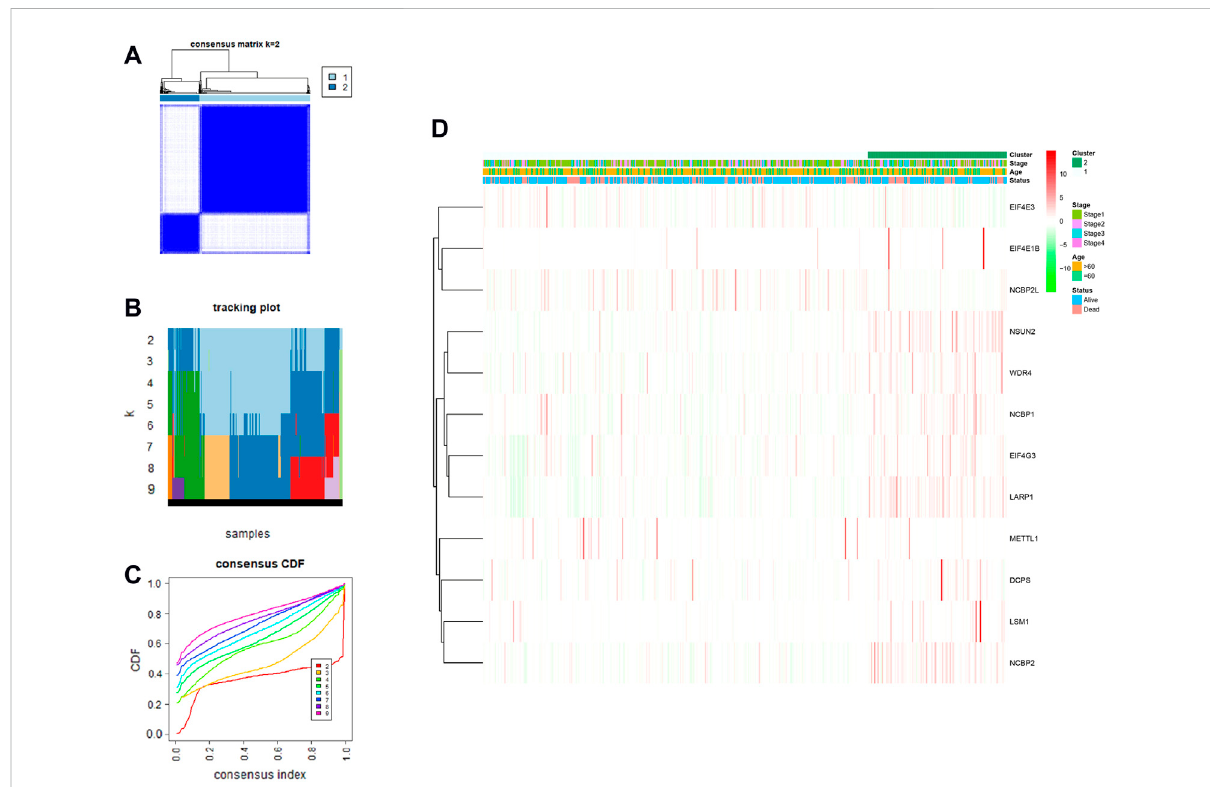
FIGURE 3 LUAD classi fi cationaccordingtom7G methylated – associatedDEGs. (A – C) Consensusclustering algorithm applied toclusterLUADsamplesin the TCGA database. The best number of clusters was two, which are de fi ned as MC1 and MC2, respectively. (D) Heatmap and clinicopathological characteristics of two